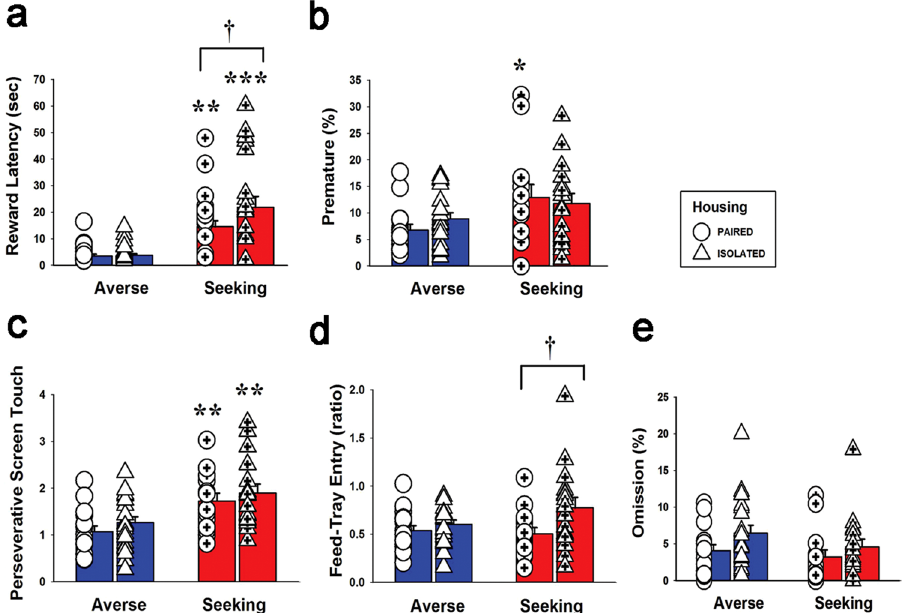
Figure 2. Analysis of behavioral parameters for the data obtained during the basal stage. The numbers of rats in each group were as shown in Fig. 1c. Values are expressed as mean + standard error of the mean. ( a ) Reward latency. ** p < 0.01; significantly higher in the seeking-paired than in the averse-paired group. *** p < 0.001; significantly higher in the seeking-isolated than in the averse-isolated group. † p < 0.05; significant differences between the seeking-paired and seeking-isolated groups. ( b ) Premature response. * p < 0.05; significantly higher in the seeking-paired compared to the averse-paired group. ( c ) Perseverative screen touch. ** p < 0.01; significantly higher in the seeking-paired compared to the averse-paired group. ** p < 0.01; significantly higher in the seeking-isolated compared to the averse-isolated group. ( d ) Feed-tray entry. † p < 0.05; significant differences between the seeking-paired and seeking-isolated groups. ( e ) Omission. There was no significant difference between